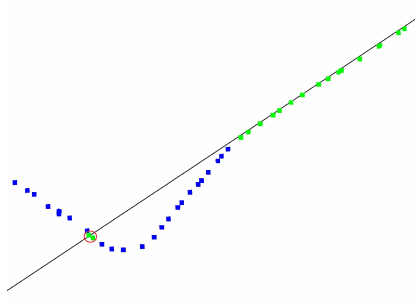
Figure 12: The false inliers are those highleted with the red cir- cle.